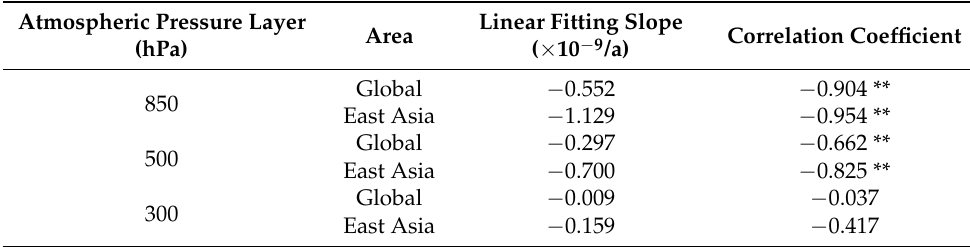
Table 3. Linear fitting of different pressure layers of CO concentration in East Asia and the world from 2003 to